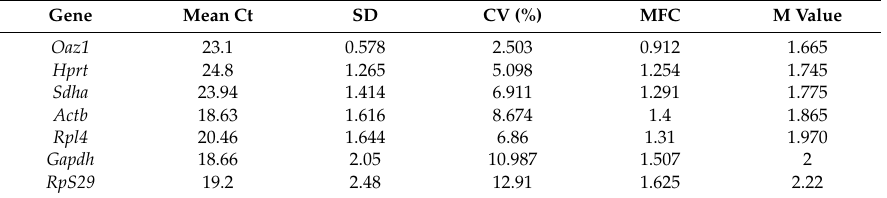
Table 2. Ranking of the seven tested housekeeping genes in thymus samples, from the most to the least stable.